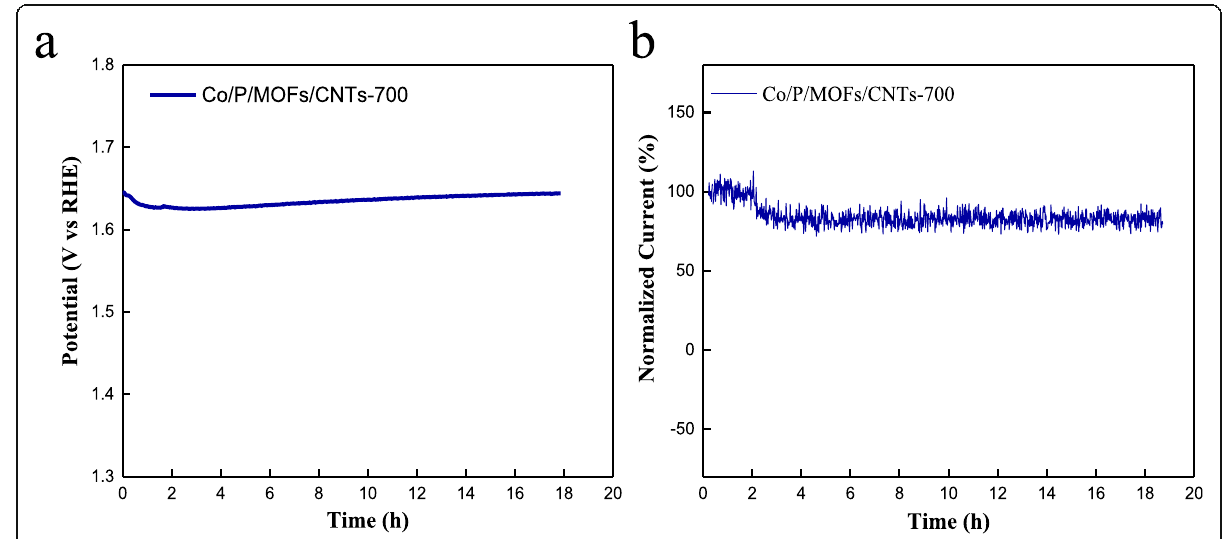
Fig. 8 a Chronopotentiometry measurement for Co/P/MOFs-CNTs-700. b Chronoamperometric response of